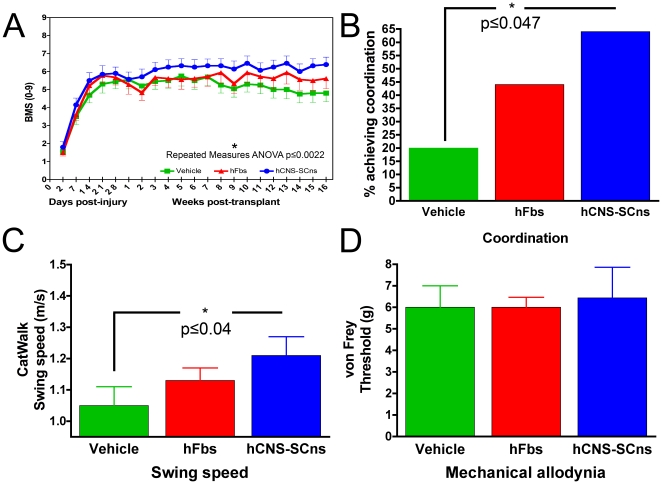
hCNS-SCns promote improved locomotor recovery on multiple tests.(A) BMS locomotor performance is significantly improved in hCNS-SCns treated animals compared to vehicle controls (repeated measures ANOVA (p≤0.0022). A Bonferroni/Dunn post-hoc analysis at week 16 revealed a significant difference between hCNS-SCns and vehicle control (p≤0.02). There were no significant differences between hFbs and either hCNS-SCns or vehicle. (B) Recovery of coordination was significantly increased in hCNS-SCns treated animals compared to vehicle controls using chi square analysis for observed frequency (p≤0.047, Fisher's Exact Test). No statistically significant differences were found comparing hFbs with vehicle or hCNS-SCns transplanted animals. Error bars are not plotted as these bars represent the absolute percentage of animals reaching criteria. (C) CatWalk gait analysis showed that hCNS-SCns treated animals exhibited significantly increased swing speed compared to vehicle treated animals (p≤0.04, ANOVA, Fisher's PLSD). (D) von Frey analysis of mechanical allodynia showed no significant differences between any of the groups (p>0.05 ANOVA).